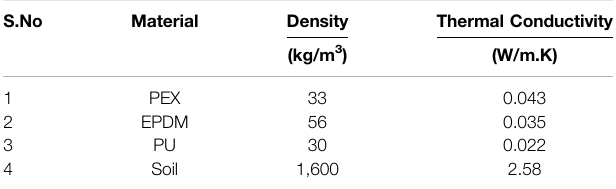
TABLE 3 | Thermal and physical properties of the three insulation materials and